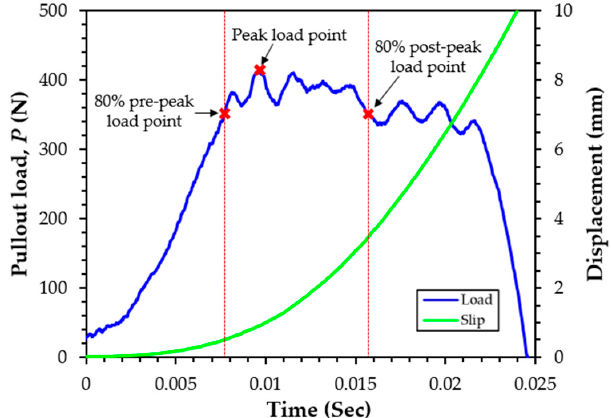
Figure 4. Measurement of loading rate from dynamic pullout test setup.